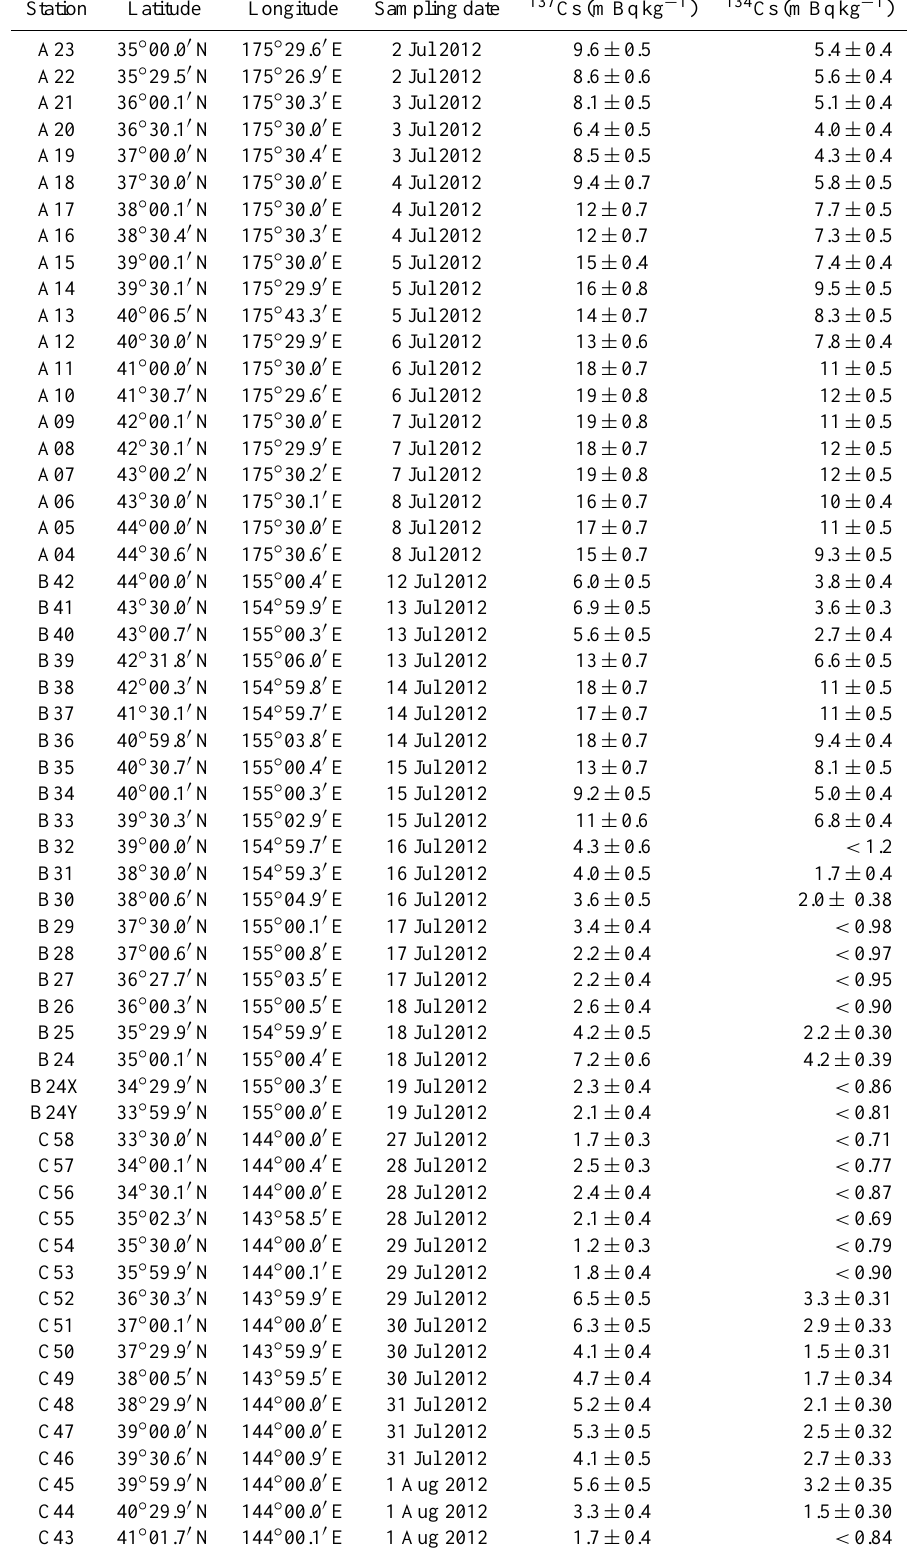
Table 3. Concentrations of 134 Cs and 137 Cs in the surface seawater collected during 2 July and 1 August 2012.